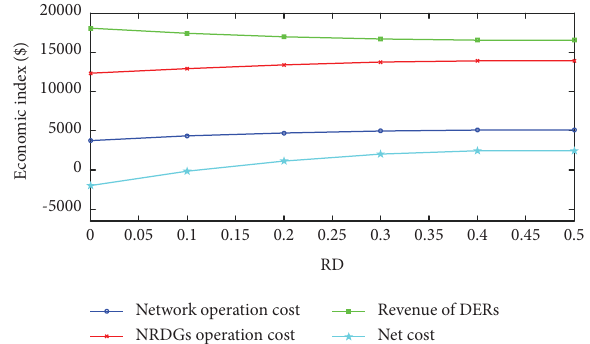
Figure 7: Curve of economic indices in robustness degree. Table 6: Values of operation and economic indices in the diferent cases for various values of robustness degree. 0